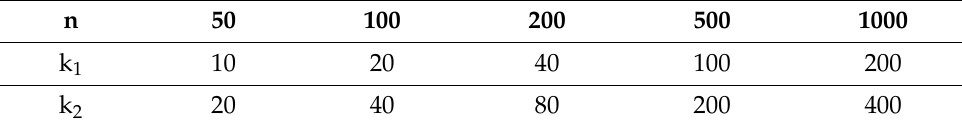
Table 1. Paris ( n , k ) for which we created UNION and BION datasets. n 50 100 200 500 1000 k 1 10 20 40 100 200 k 2 20 40 80 200 400 Each triple ( R , G , H ) was saved as a triple of txt files. For